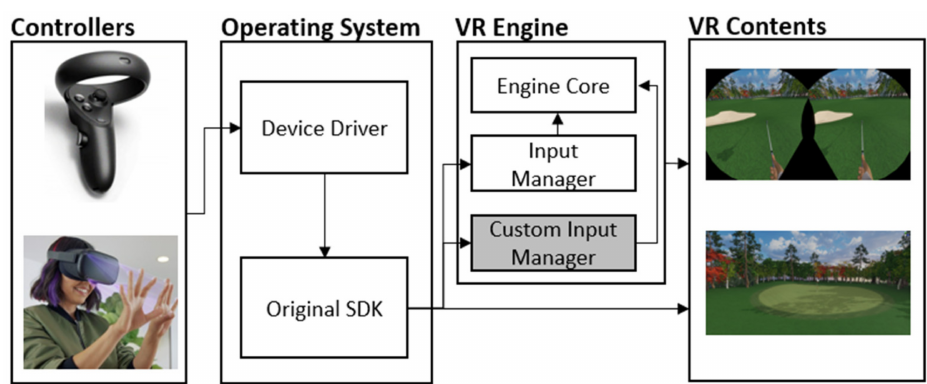
Figure 4. Content development flow when using non-standard input